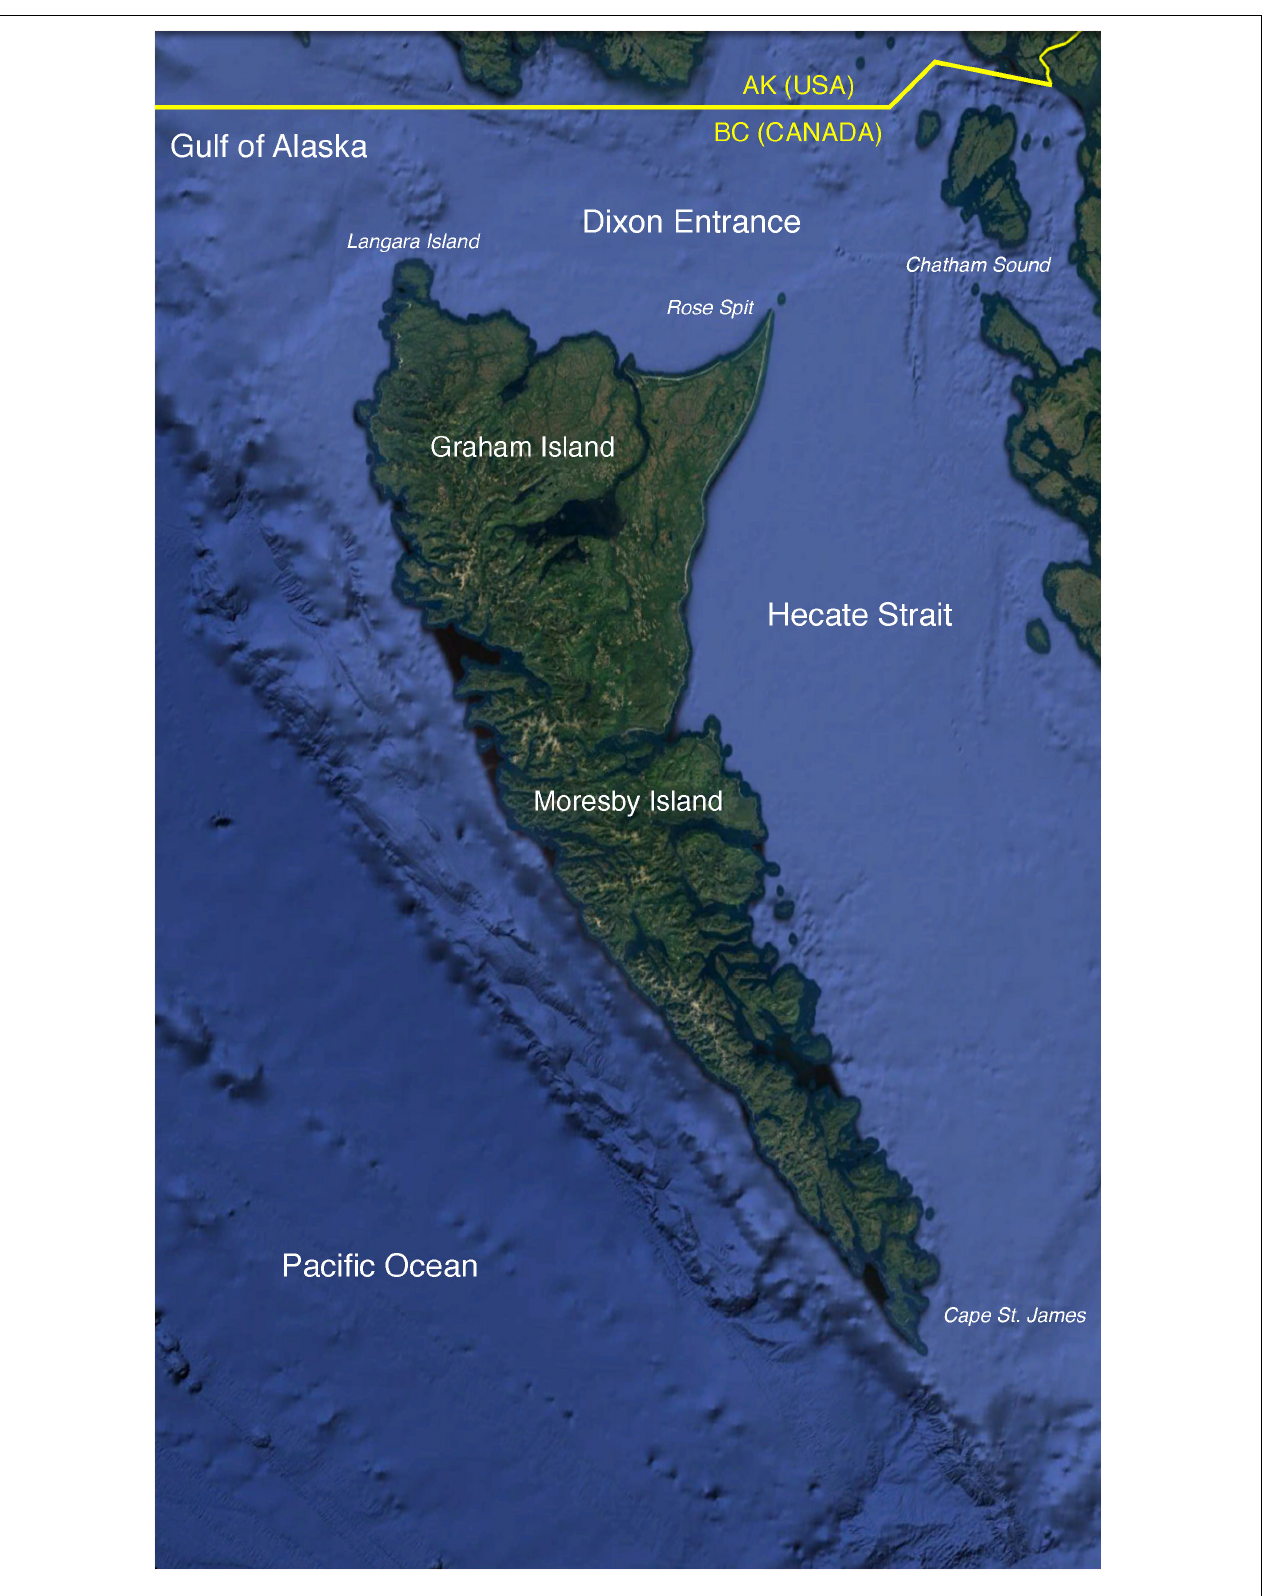
FIGURE 1 | The study area ( ∼ 81,000 km 2 ) located in the southeastern Gulf of Alaska and surrounding the archipelago of Haida Gwaii. Base map obtained from Google Earth Pro. Data LDEO-Columbia, NSF, NOAA. Base map ©2018 Google. Image Landsat/Copernicus. Data SIO, NOAA, U.S. Navy, NGA, GEBCO.